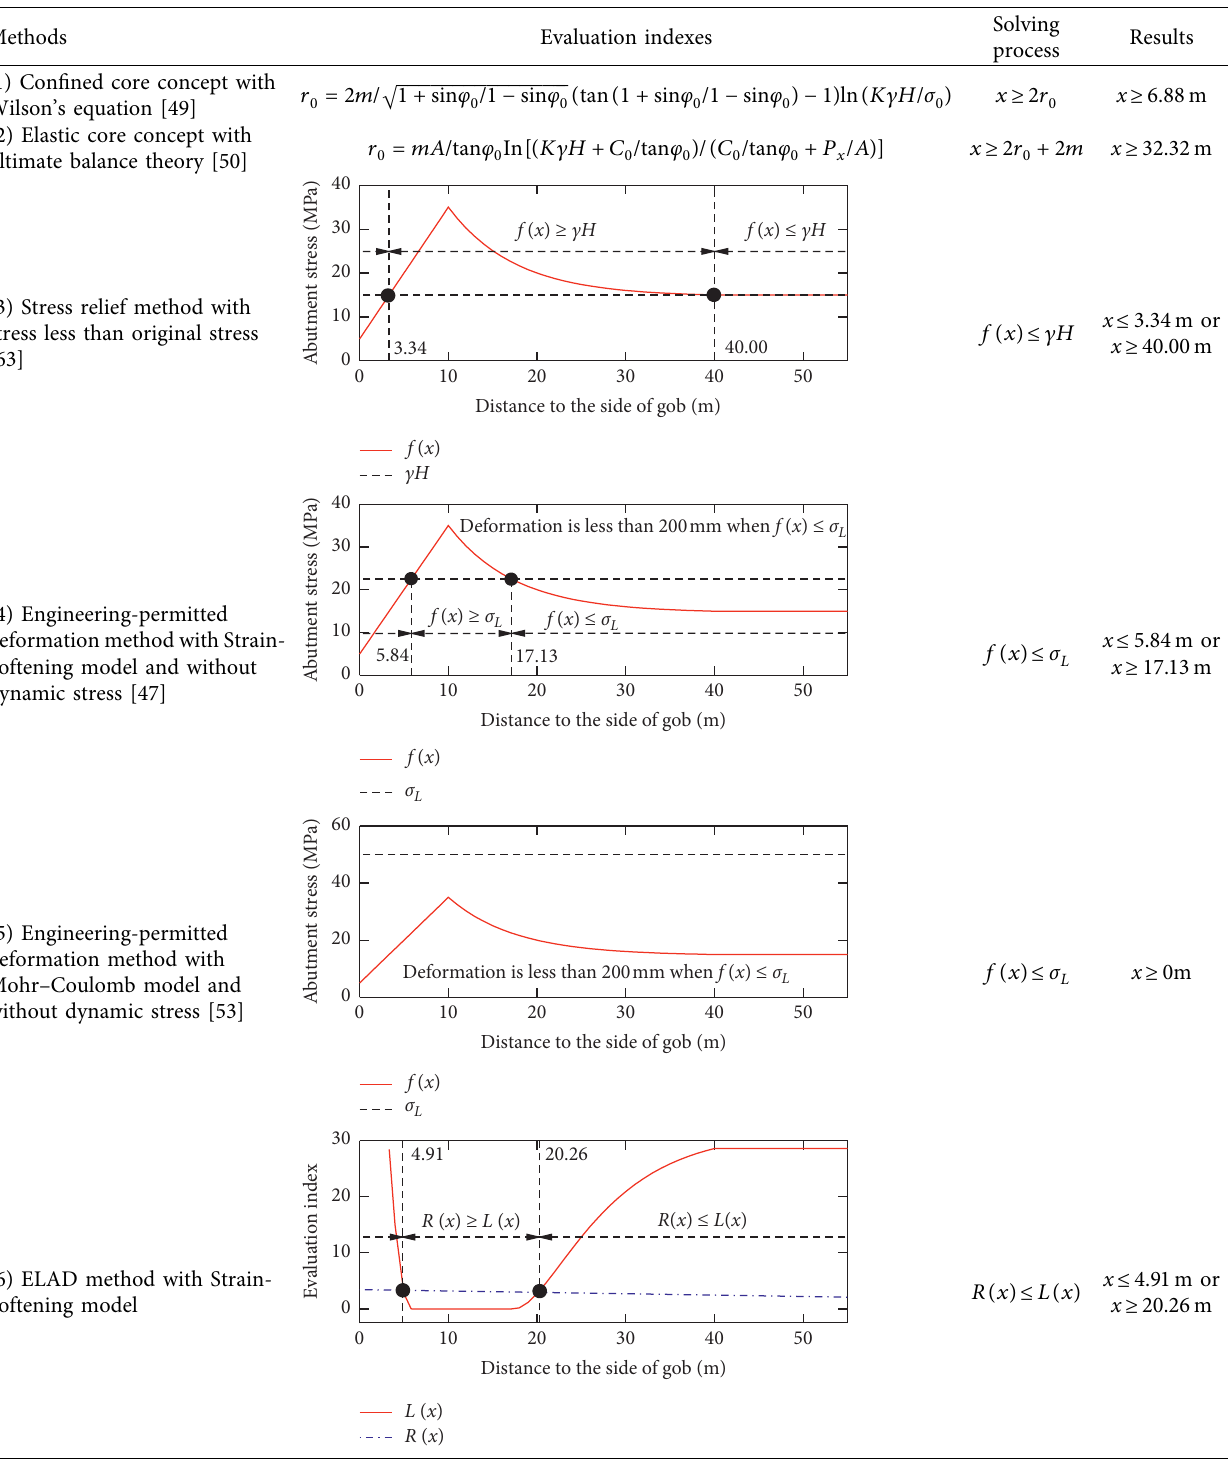
Table 5: Underground entry layout